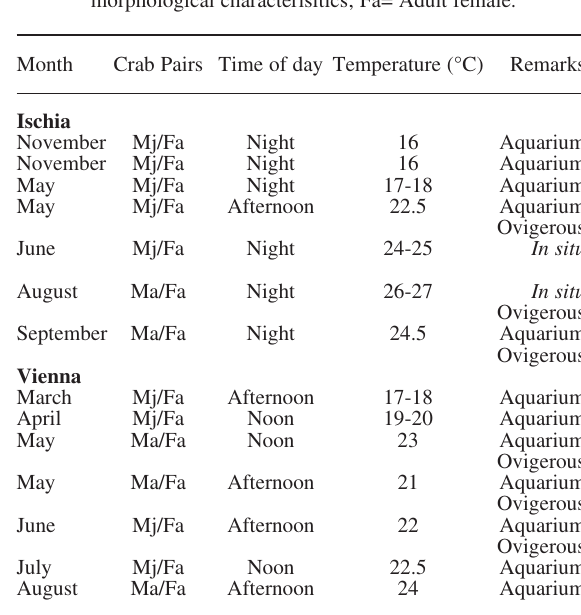
T ABLE 4. – Observed copulations in Maja crispata. Mj= Male with juvenile morphological characteristics; Ma= Male with adult morphological characterisitics; Fa= Adult